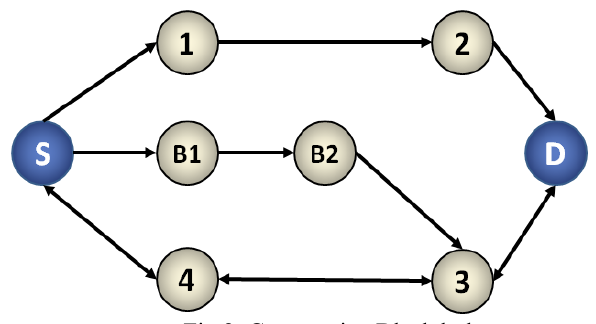
Fig.2. Cooperative Black hole